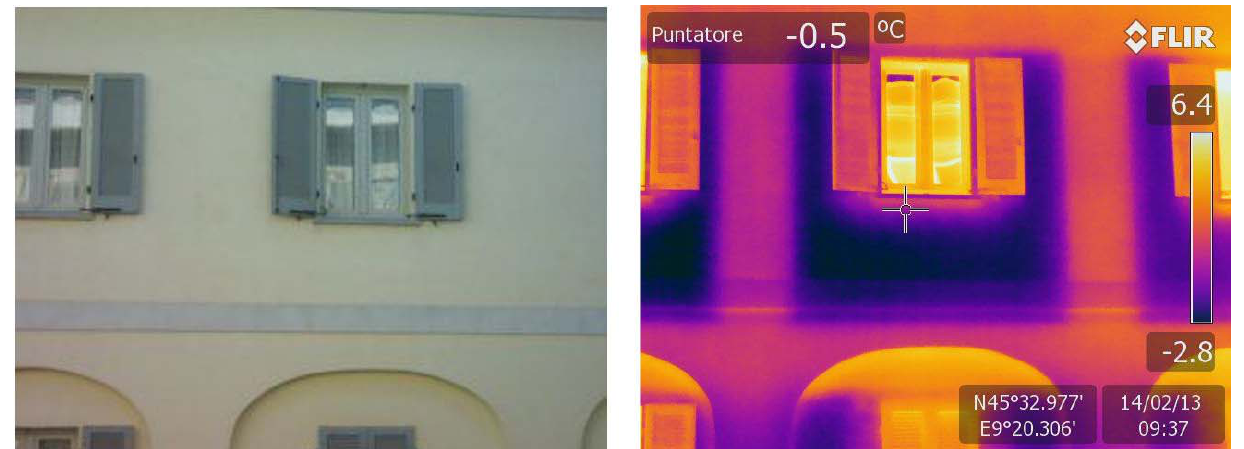
Figure 4. Visible image and thermogram of the municipal